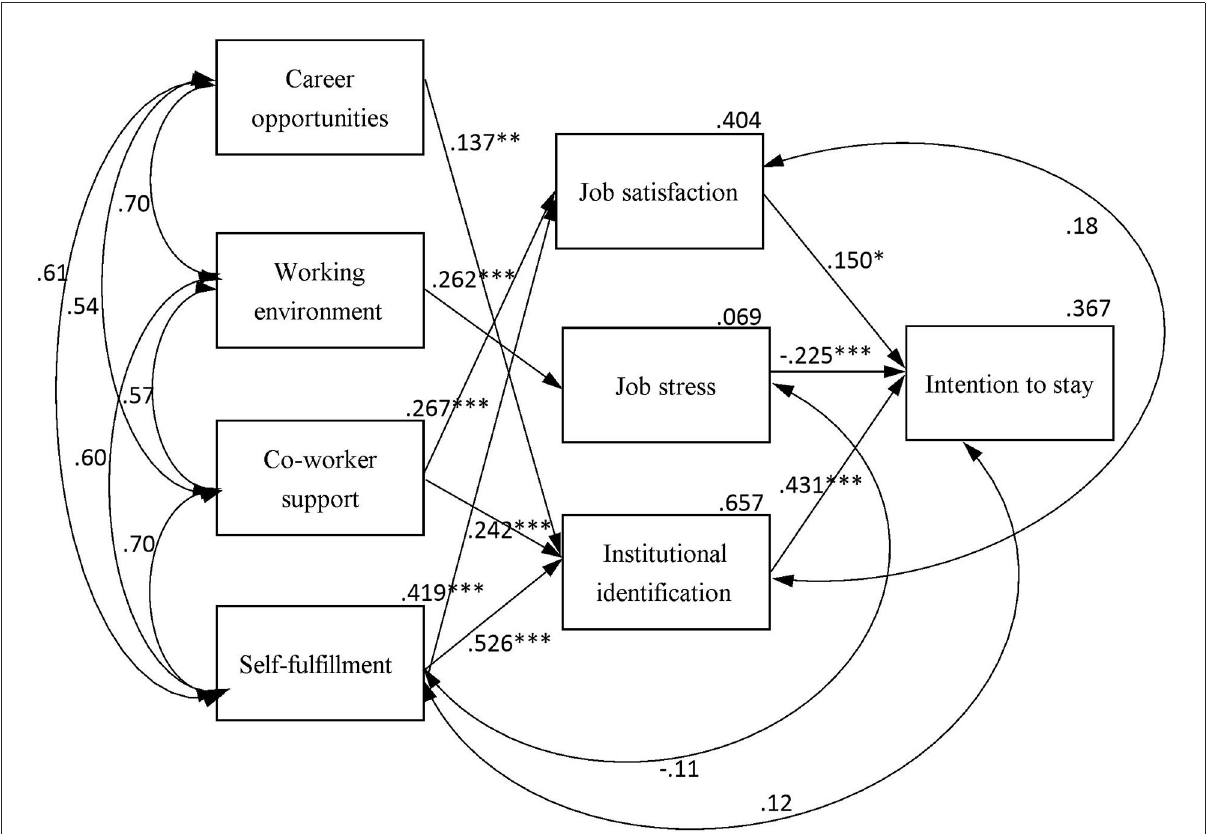
FIGURE1 Path diagram of the conceptual model of intent to stay (CMIS) (path coefficients are indicated in the path diagram). * p < 0.05, ** p < 0.01, *** p <